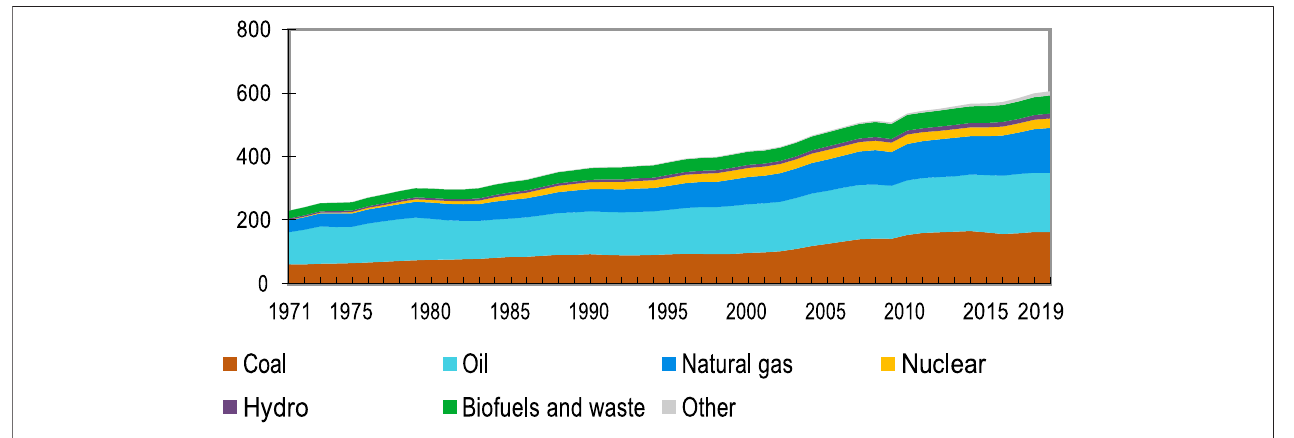
FIGURE 5 | World total energy supply between 1971 and 2019 (United Nations, 2019a; International Energy Agency,